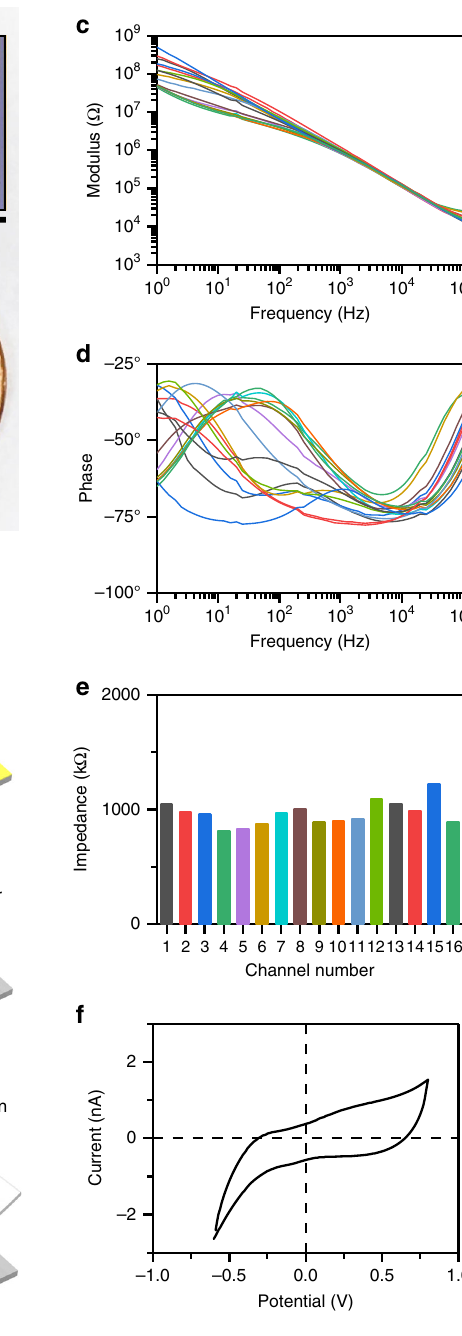
Fig. 1 Graphene microelectrode array fabrication and electrochemical characterization. a Design of the graphene microelectrode array. Each electrode is a 100 µ m×100 µ m square and the spacing in-between two adjacent electrodes is 300 µ m (edge-to-edge). Scale bar, 500 µ m. b Fabrication of graphene microelectrode arrays. Step 1: clear 50 µ m-thick PET fi lm. Step 2: 10 nm Cr and 100 nm Au sputtered onto the PET fi lm. Step 3: metal wires patterned with photolithography and wet-etching. Step 4: graphene transfer with bubbling method. Step 5: graphene contact pads patterned with photolithography and oxygen plasma-etching. Step 6: spin-coating of SU-8 and patterning of openings with lithography. c , d Electrochemical impedance spectroscopy of all 16 channels on an array. e Impedance at 1 kHz; channels have an average impedance of 963 k Ω . f Cyclic voltammetry of a representative channel shows no redox size along the Z axis size was observed for beads below microarray phantom sample above mounting medium containing 1 µm fl uorescent polystyrene beads at a low concentration (Supplementary substrate and graphene electrode. Fig. 5). Compared with beads imaged beside the graphene microarray, a moderate (1.2- to 1.4-fold) increase in apparent bead size (full-width half-maximum (FWHM) within the imaging plane, i.e., across X and Y axis) and a 1.75-fold increase in apparent bead